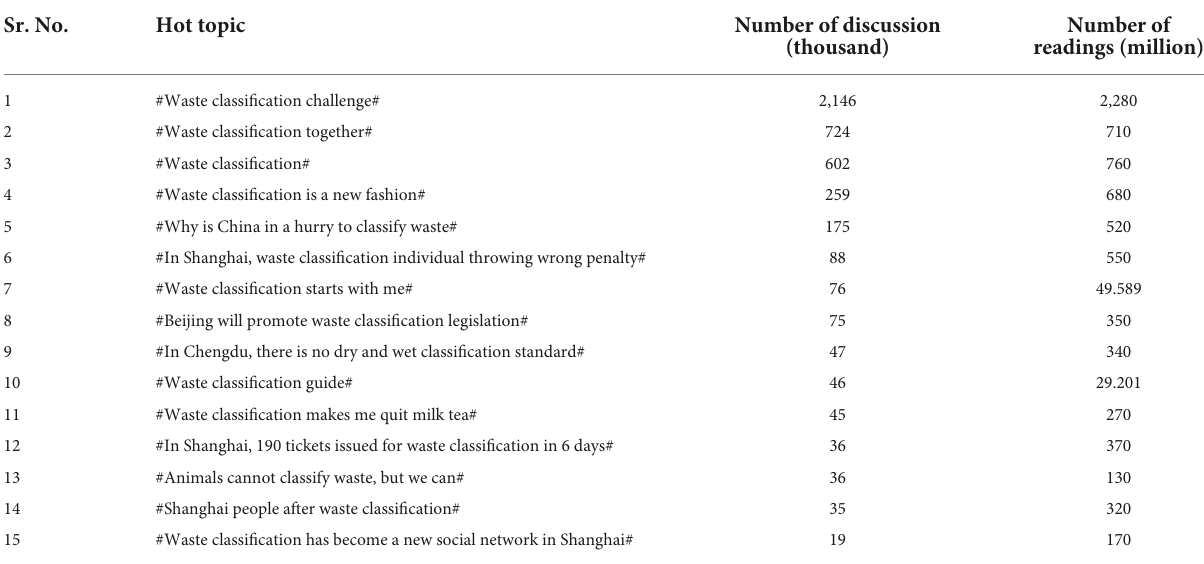
FIGURE3 “Waste classification” Baidu Index.